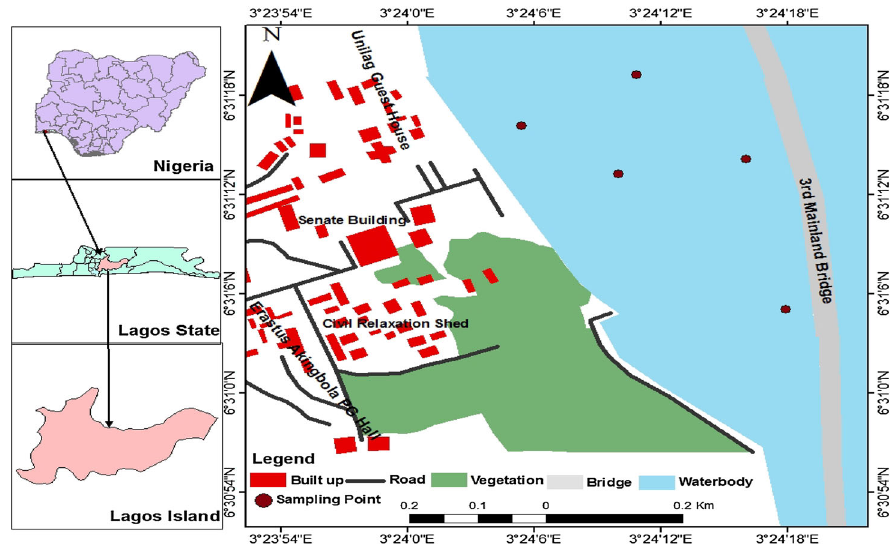
Fig. 1 Map of Lagos Lagoon showing sampling